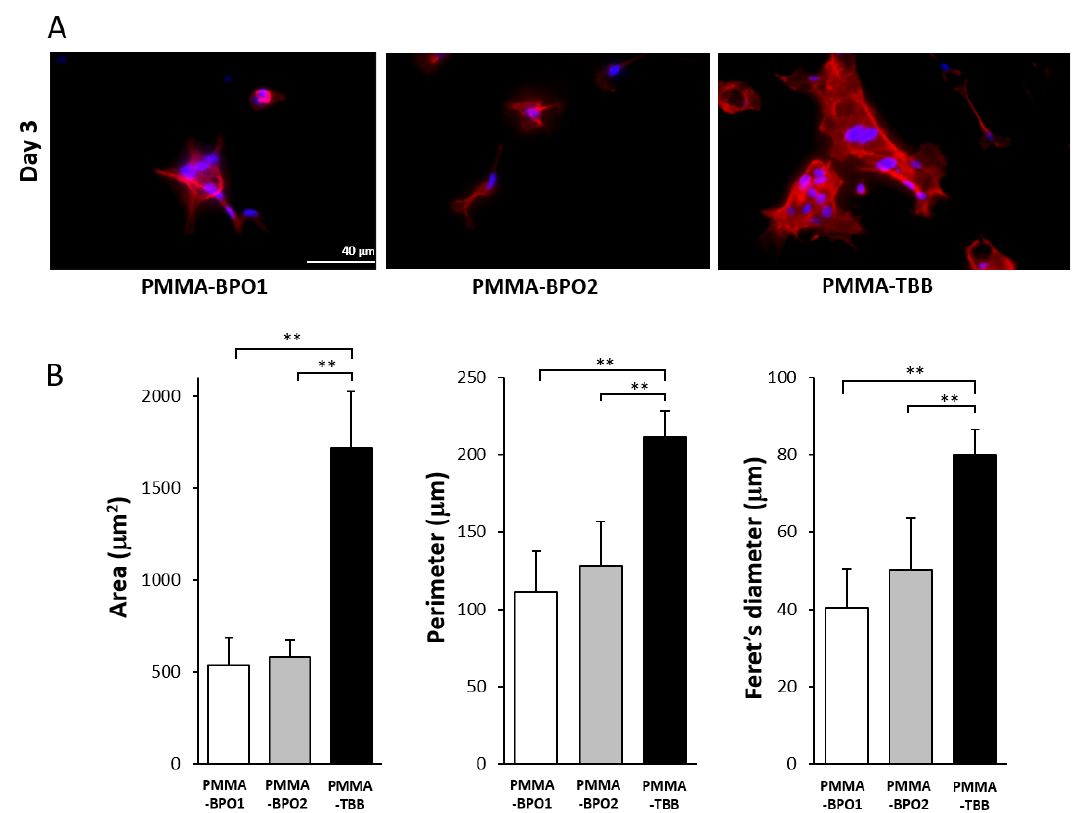
Figure 3. Representative high-magnification fluorescence microscopy images of the spreading osteoblasts 3 days after seeding on three different bone cement surfaces. ( A ) Fluorescence microscopic images of osteoblast following immunochemical staining for cytoskeletal actin (red) and nucleus (blue). Scale bar = 40 µm. ( B ) Histograms for cytomorphometric parameters measured from the images. Each value represents the mean ± standard deviation of six measurements ( n = 6). ** p < 0.01, one-way ANOVA followed by a Bonferroni test. Scale bar = 40 µm.